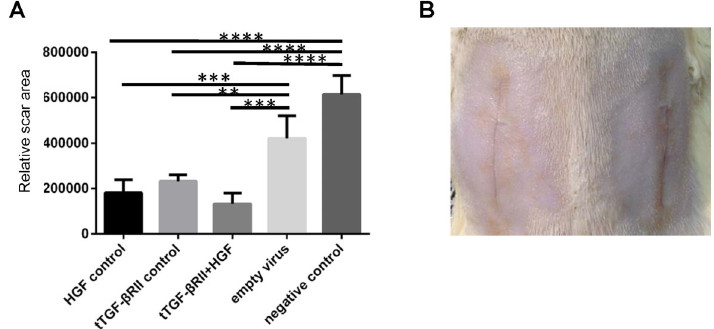
Figure 4. Relative scar area in each group. A , Quanti fi cation of the relative wound scar area revealed that the wounds in the experimental (t-TGF- b RII + HGF), HGF control, and t-TGF- b RII groups healed with less scarring compared with those in the empty virus and blank groups. The result was most prominent in the experi- mental group. Data are reported as means ± SD. **P o 0.01, ***P o 0.001, ****P o 0.0001 (Student-Newman-Keuls test). B , On macroscopic inspection, the treated wound (left side) exhibited less visible scarring compared with the control wound (right side) at 14 days after wounding. t- TGF- b RII: truncated transforming growth factor- b type II receptor; HGF: hepatocyte growth